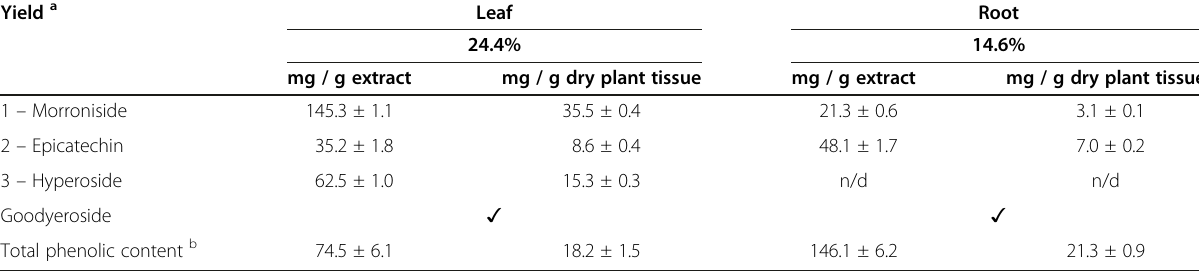
Table 1 Quantitation of marker compounds in leaf and root extracts of Sarracenia purpurea by HPLC-DAD Yield